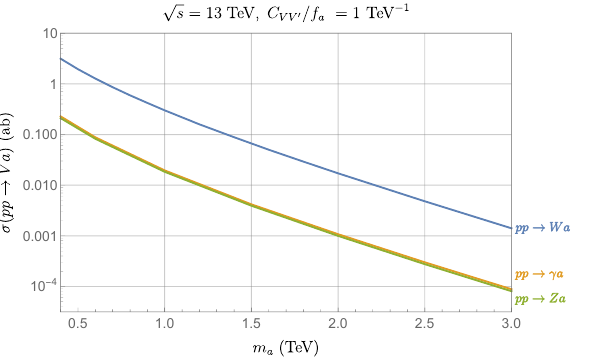
Figure 4 . Different associated production rates as a function of m a at the 13-TeV LHC, fixing C V V 0 /f a = 1 TeV − 1